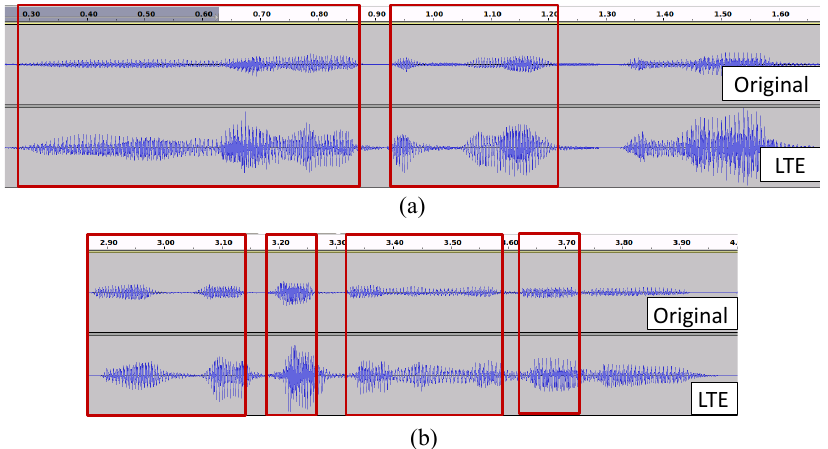
Figure 4. ( a ) Aligned segments of original and mobile LTE re-recorded speech, ( b ) Misaligned segments inside recording those need to be filtered out to train the regression model.